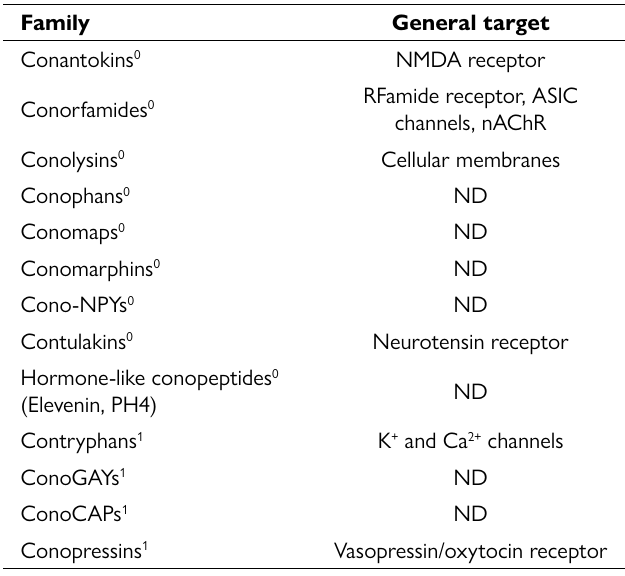
Table 1. Disulfide-poor conopeptides and their known